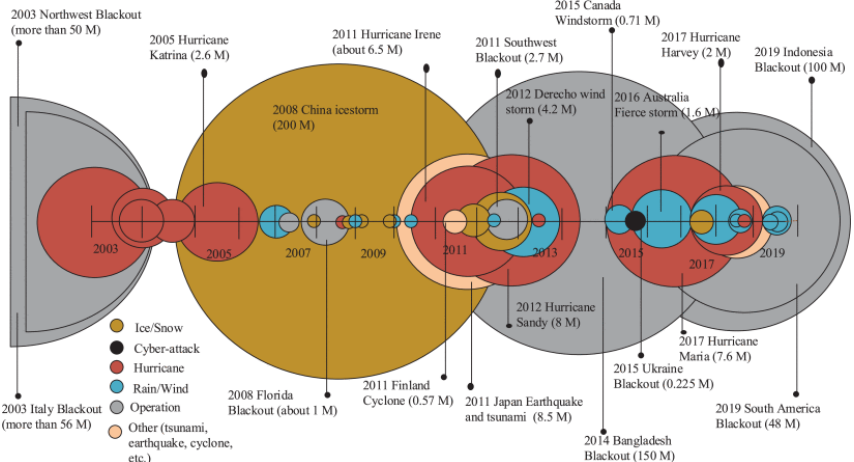
Figure 3. Examples of high impact low frequency (HILF) events, where M denotes the number of customers without power